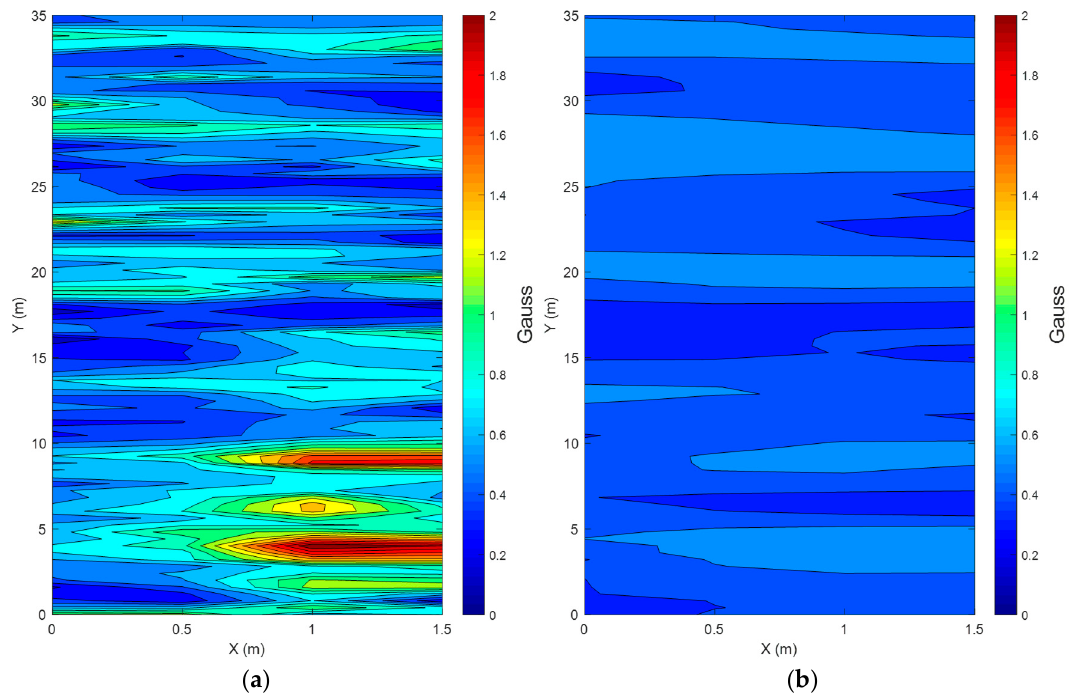
Figure 2. Magnetic anomaly maps in the corridor (( a ) is magnetic anomaly around the foot, and ( b ) is magnetic anomaly around the waist).